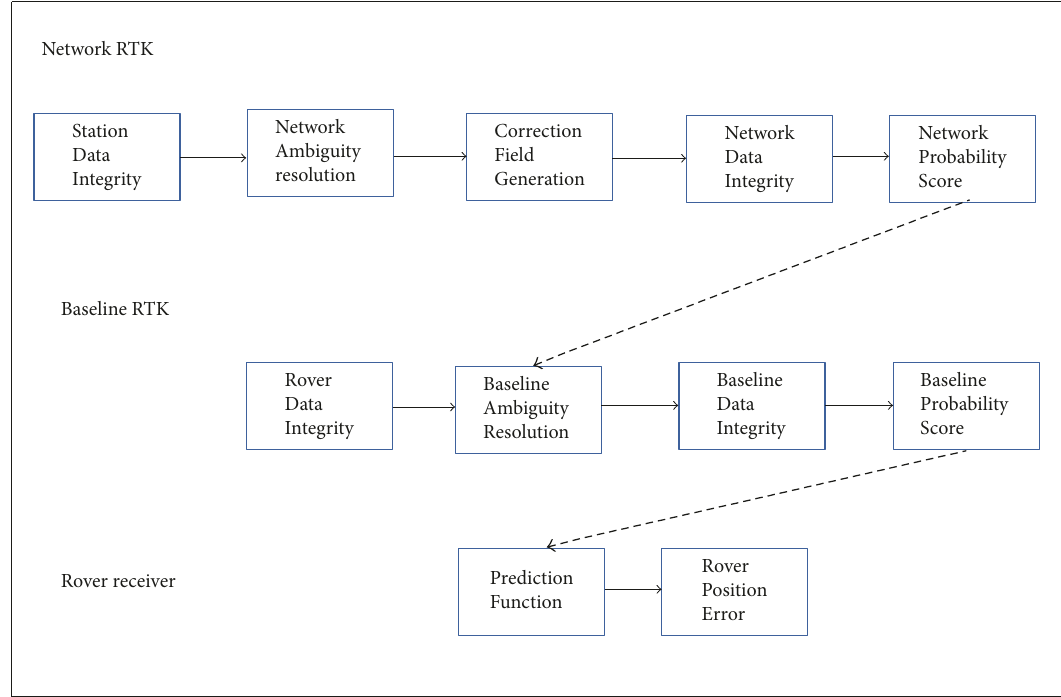
Figure 2: Network real-time kinematic processing chain main modules. Dotted lines describe the components dependency from different